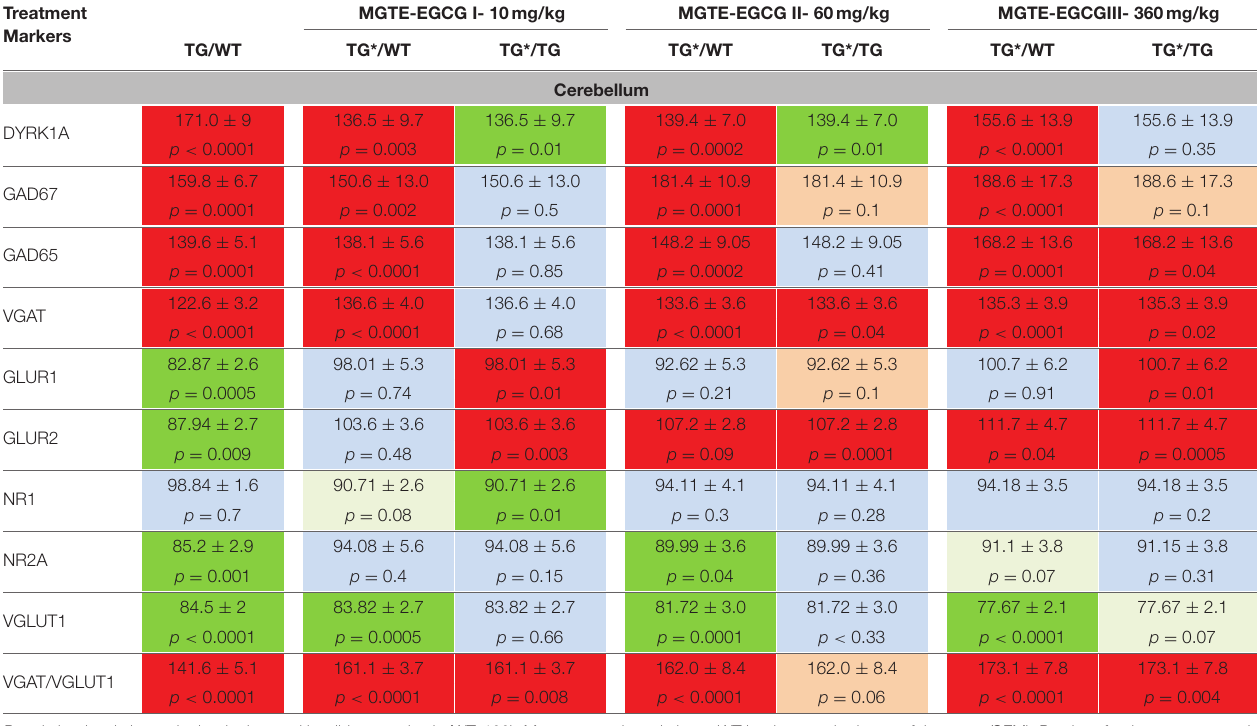
TABLE 5 | Protein levels of markers of inhibition and excitation pathways for WT and mBACtgDyrk1a (Tg) in cerebellum following treatment with 3 doses of MGTE extract. Treatment